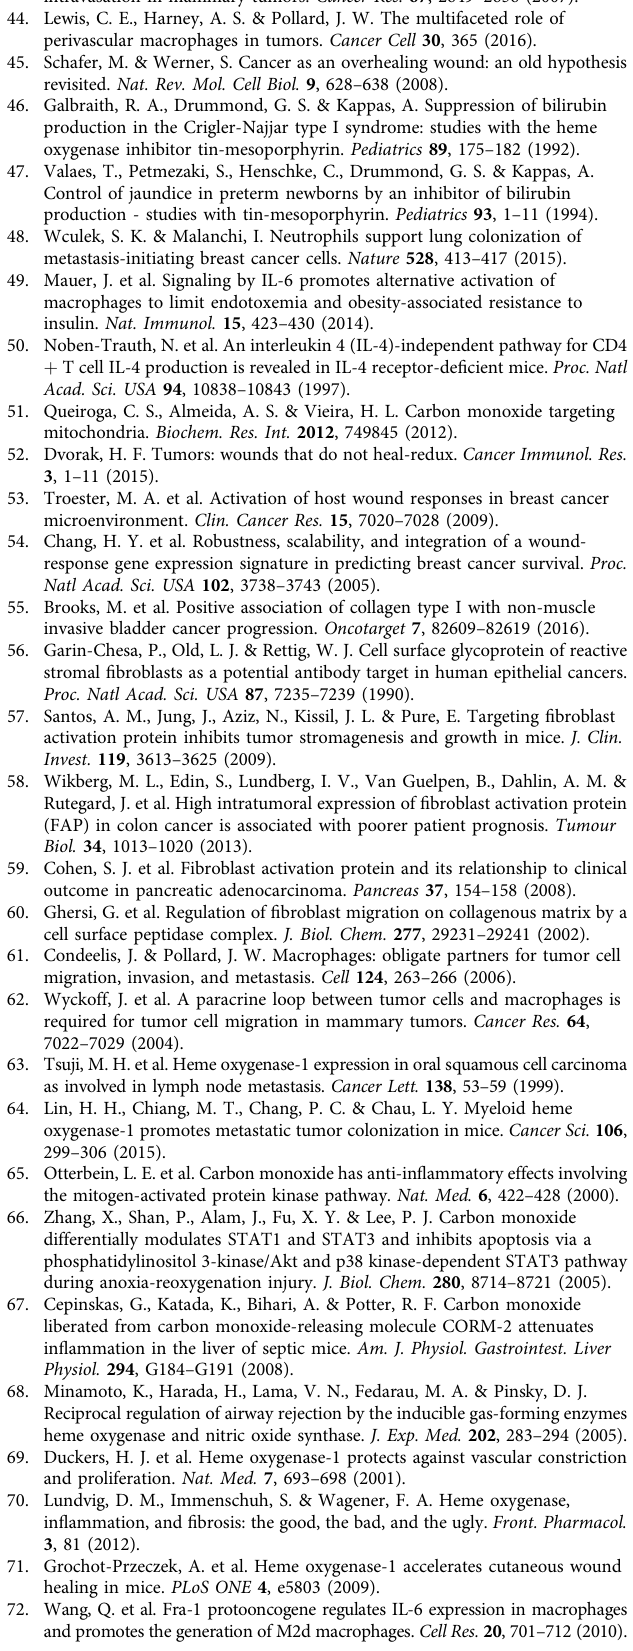
Figdor, C. G. The heme-heme oxygenase system: a molecular switch in wound healing. Blood 102 , 521 – 528